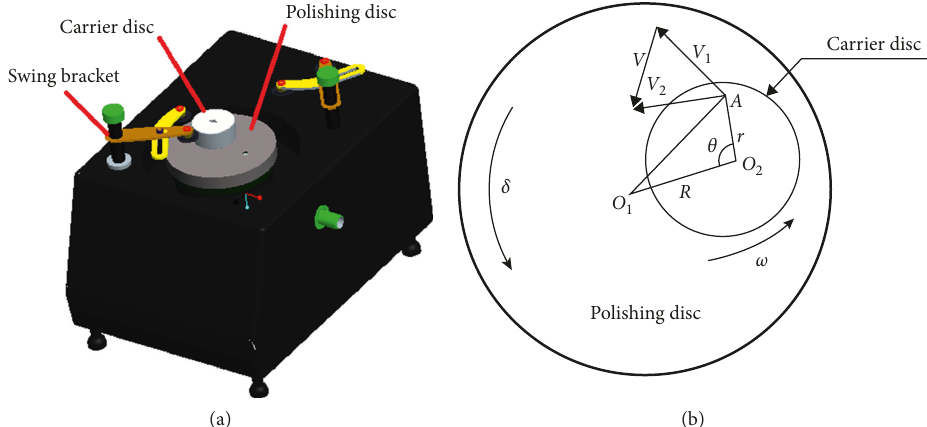
Figure 1: Illustration of annular polishing. (a) Model of annular polisher; (b) motion analysis of annular polishing. Reproduced from Zhang et al. [15] (under the Creative Commons Attribution License/public